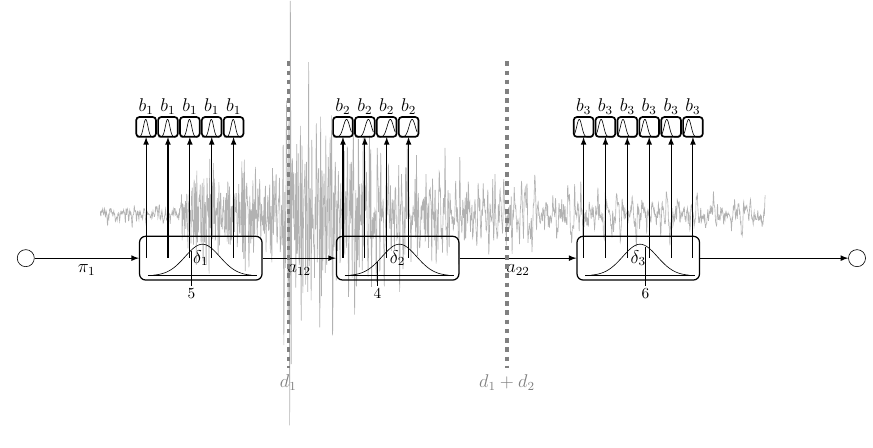
Fig. 4. Hidden semi-Markov Model. The duration probabilities δ 1 , 2 , 3 are plotted in the states (lower rectangles). Directly when a state is entered, a sample is drawn from δ , e.g. five in the part. Consequently five observations are generated from the observation probability b 1 and then the next state is entered.